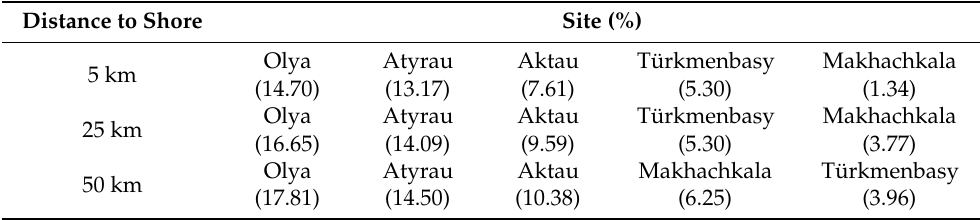
Table 4. The top five rated capacities sorted in a descending order (reported to a 13 m/s rated speed). Distance to Shore